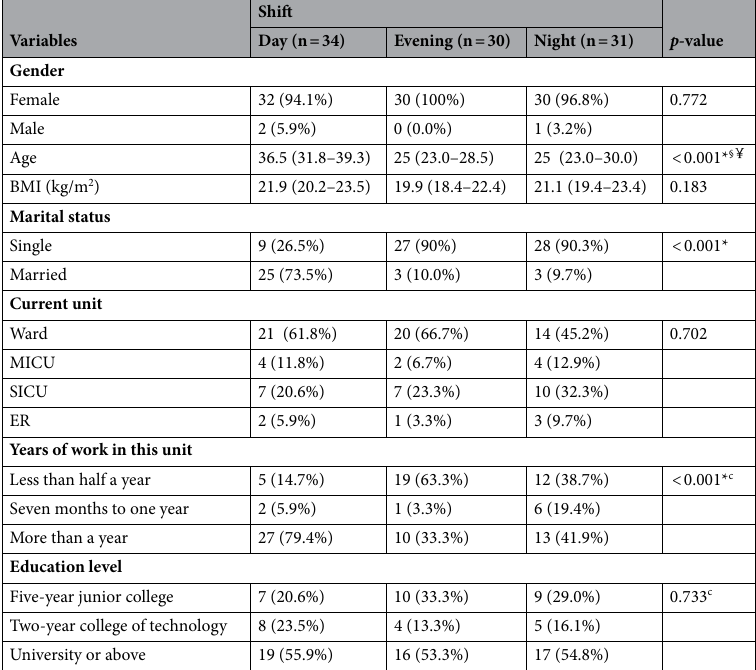
Table 1. Participant characteristics of three shift Nursing Staffs. BMI, body mass index; MICU, Medical Intensive Care Unit; SICU, surgical intensive care unit; ER, emergency room. * p -value < 0.05( § Day shift v.s. evening shift; ₤ evening shift v.s. night shift; ￥ Day shift v.s. night shift). The power after calculation and